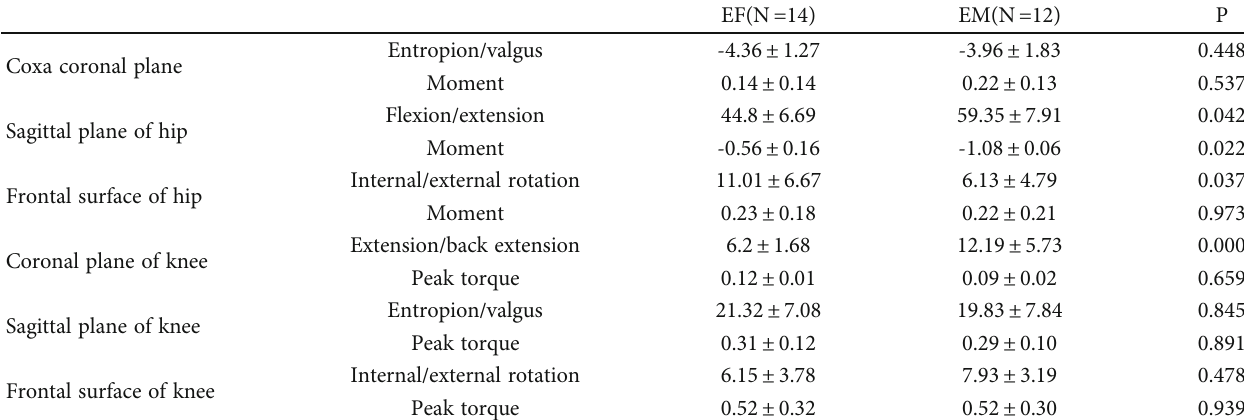
Table 3: Comparison results of kinematic parameters of male and female soccer players at landing time (M ±